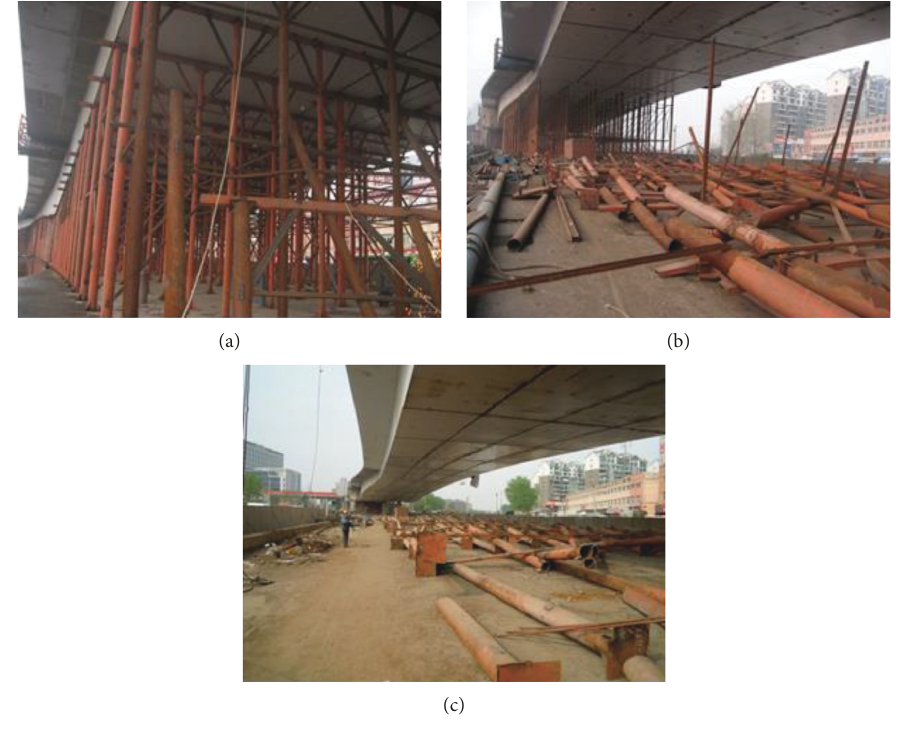
Figure 5: Scaffolding dismantling process.